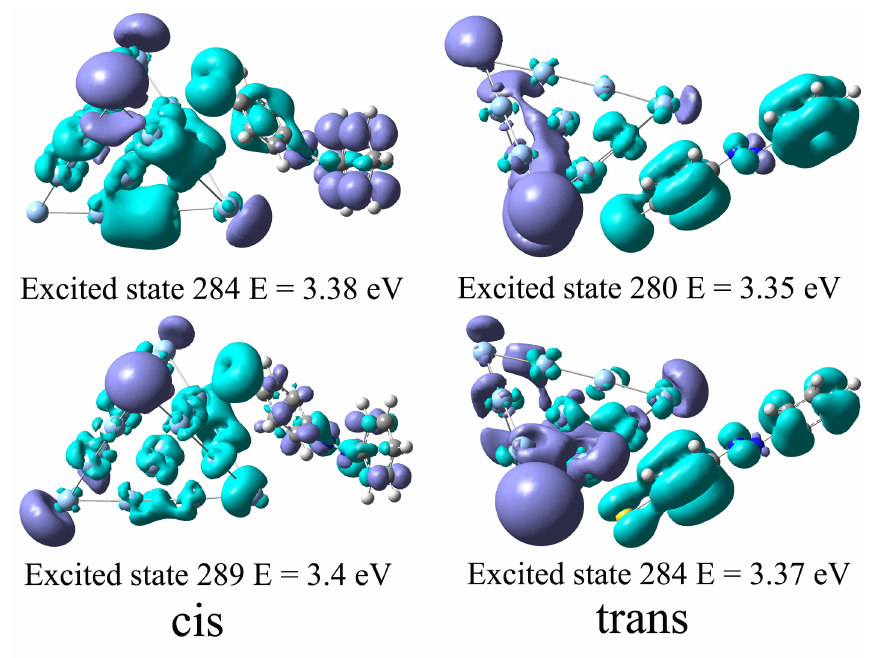
Figure 6. The charge density difference of excited states correspond to the two strong transitions around the 3.5 eV for Ag20-cis and Ag20-trans complexes,